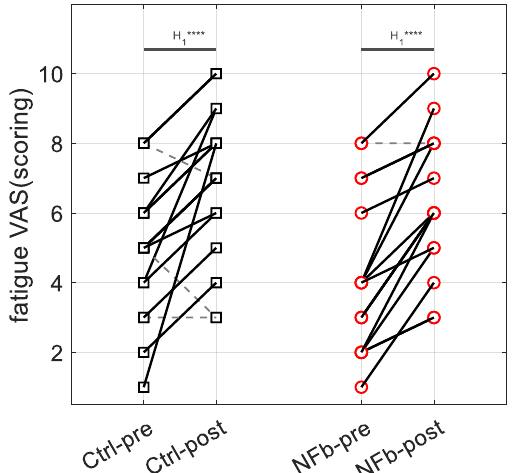
Figure 5. Effect of the intervention on subjective fatigue report by visual analog scale (VAS) of fatigue for the control (Ctrl) and the neurofeedback (NFb) groups. Dashed gray lines indicate decreases while solid black lines indicate increases. Interpretation scale: H1 **** means extreme evidence for the alternative